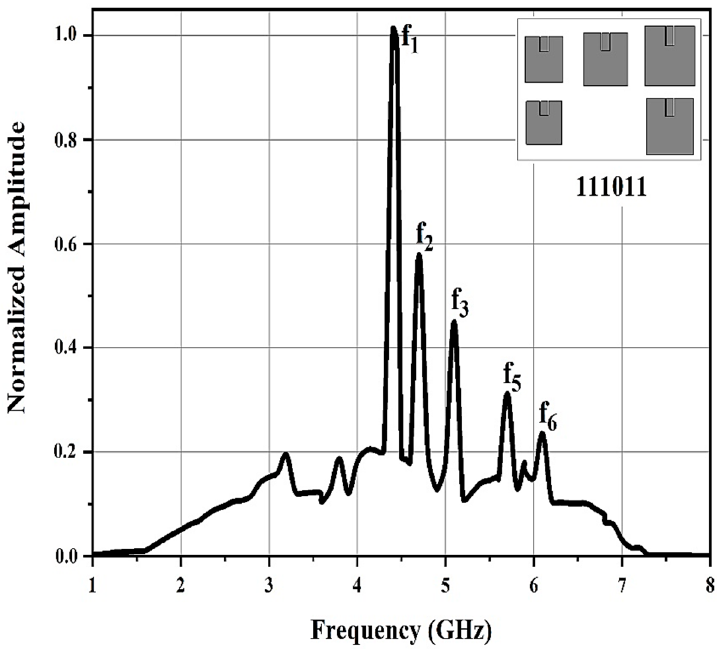
Figure 9. Frequency spectrum of the antenna mode backscatter for the chipless RFID tag containing data ‘111011’.